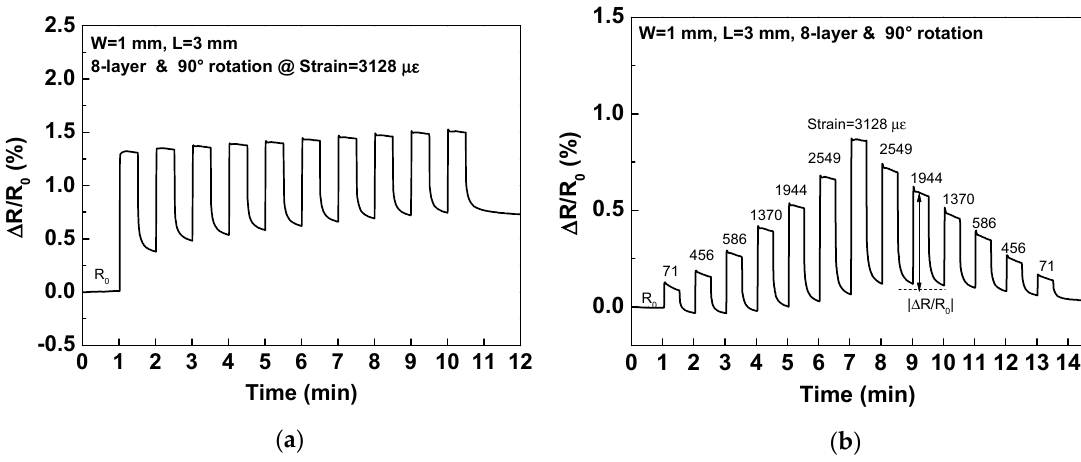
Figure 10. Stretch/release transient response as a function of various strains from 71 to 3128 µ ε for eight-layer strain sensor with ( a ) unidirectional printing; ( b ) 180° rotation. 0 1 2 3 4 5 6 7 8 9 10 11